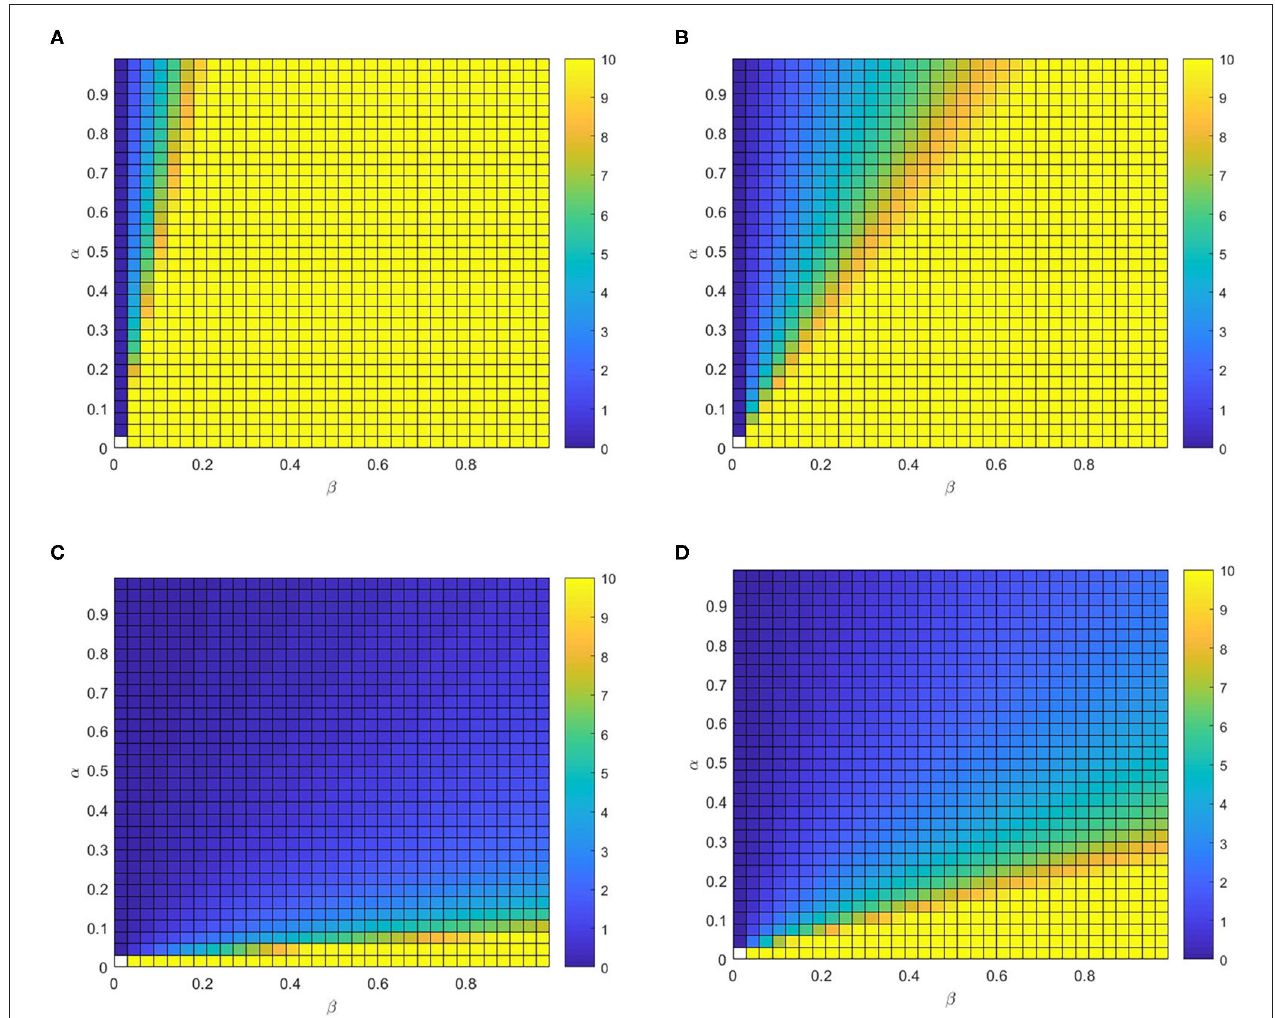
FIGURE 10 | The control reproduction number R V . Full phase diagram α − β for the identical multiplex depicted before. (A) η = 0.02, δ = 0.8, (B) η = 0.02, δ = 0.2, (C) η = 0.4, δ = 0.2, and (D) η = 0.4, δ =